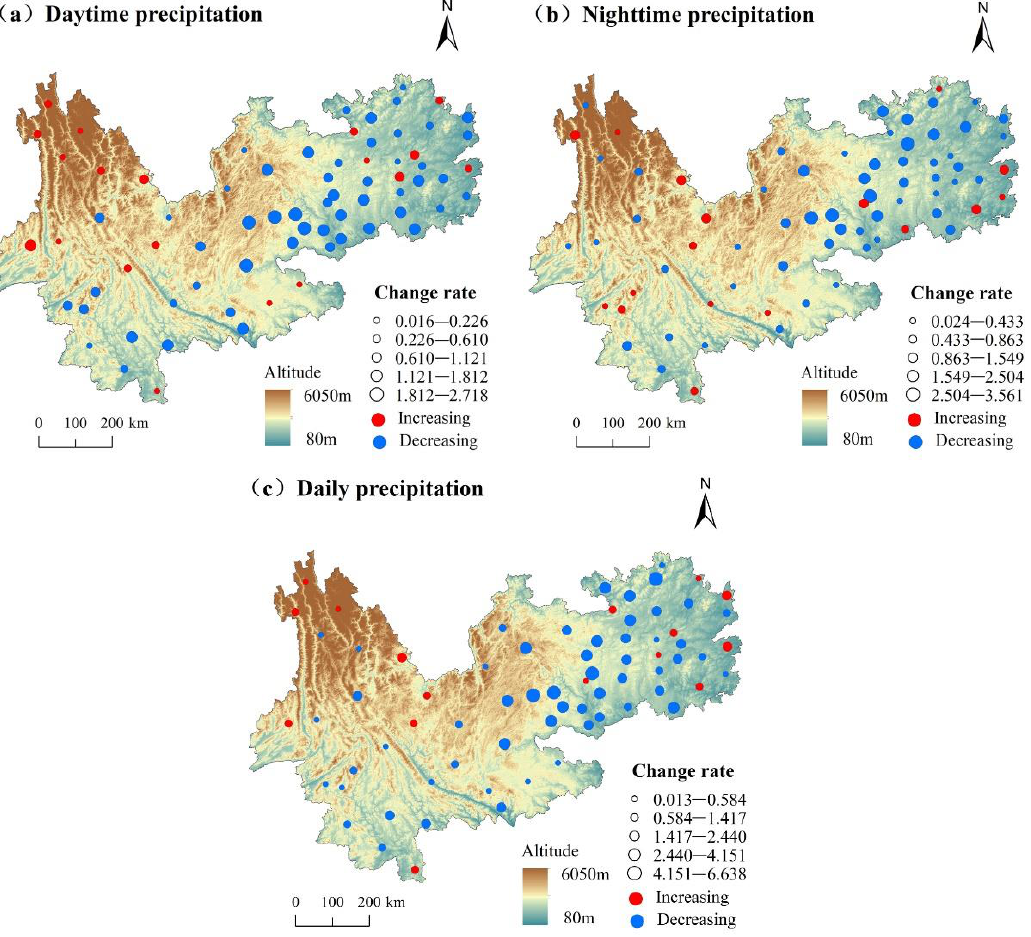
Figure 6. Spatial pattern of daytime, night-time and daily precipitation change rate (mm/yr) on Yunnan – Guizhou Plateau from 1960 to 2017.